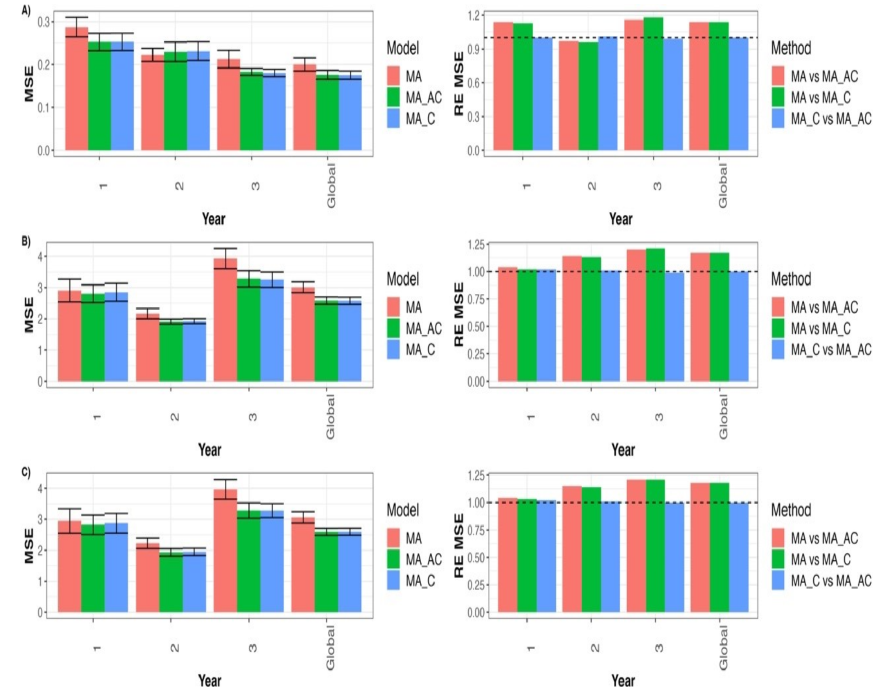
Figure 1. Prediction performance in terms of mean square error (MSE) for models MA, MA_C, and MA_AC for each trait in each environment and across environments (Global) under untested lines in tested environments cross-validation strategy. The relative efficiencies (RE_MSE) were computed to compare models MA_C vs. MA_AC, MA vs. MA_C, and MA vs. MA_AC. ( A ) for GY trait, ( B ) for DTF trait, and ( C ) for DTH